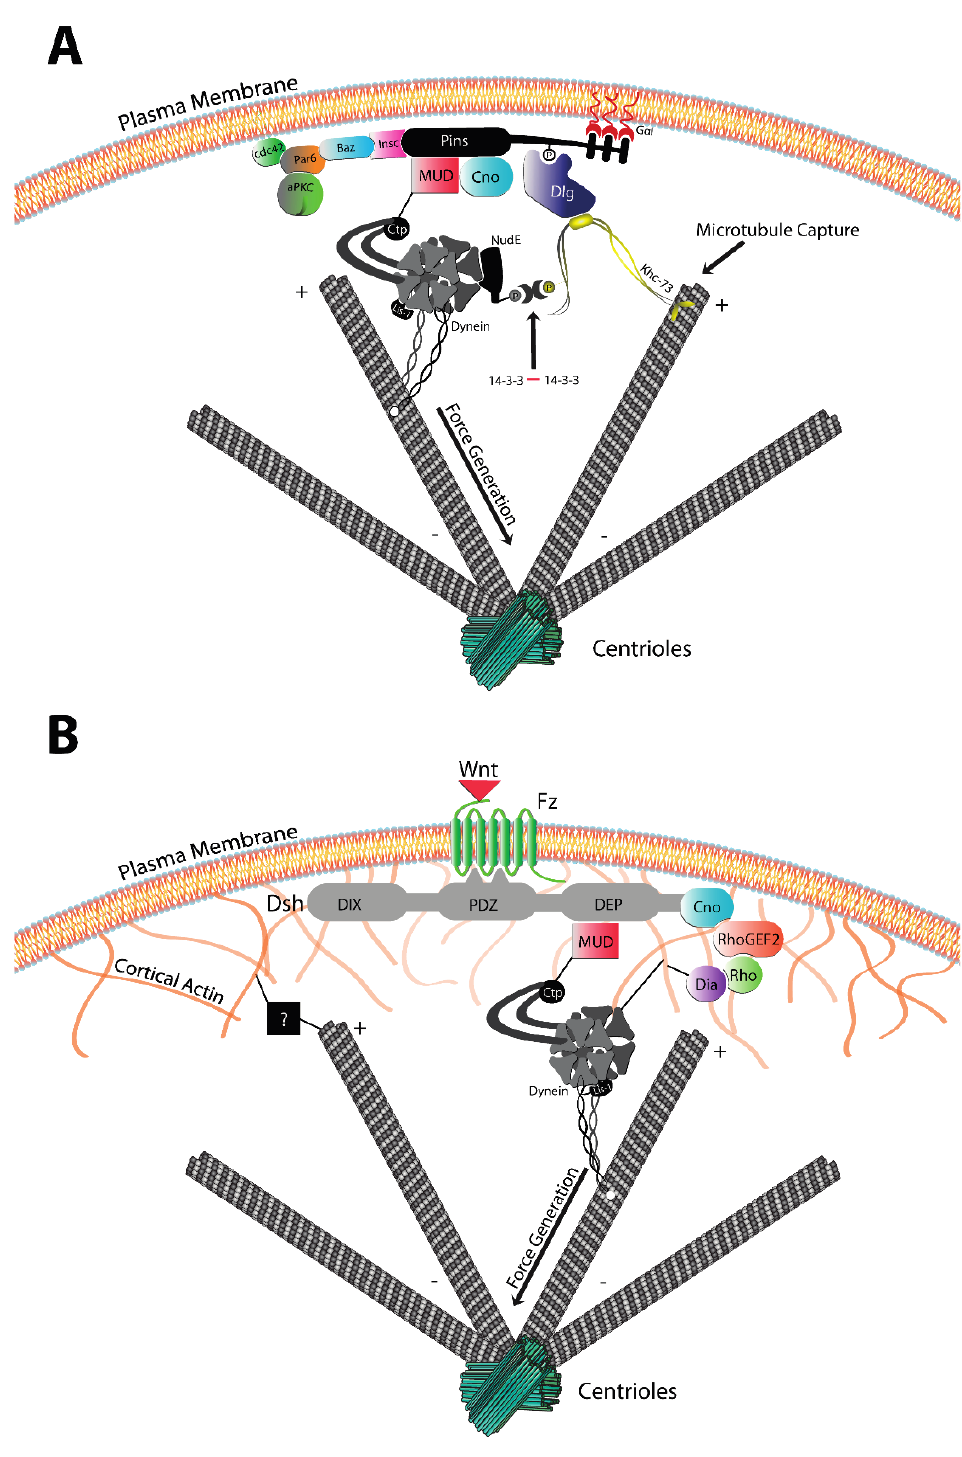
Figure 4. Molecular models of spindle orientation complexes. ( A ) Pins mediates spindle orientation through two synergistic pathways: a microtubule-capturing complex consisting of Dlg/Khc-73 and a force-generating complex consisting of Mud/Dynein. These two pathways are linked through a 14-3-3 dimeric bridge; ( B ) Fz/Dsh also utilizes two pathways to position the mitotic spindle: the Mud/Dynein complex likely provides an analogous force-generating function, whereas the Dsh C-terminus initiates cortical F-action polymerization through Rho/Diaphanous (Dia) that might serve a spindle capturing role through an unknown